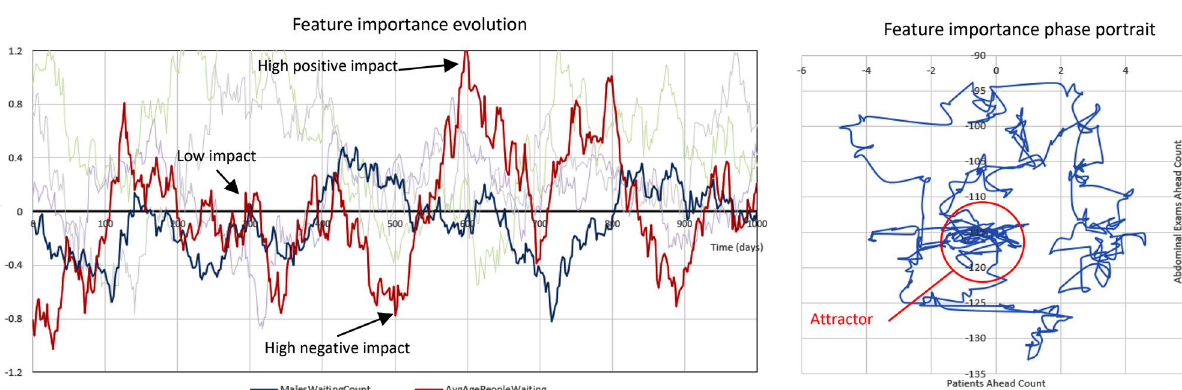
Figure 6. Left: Feature contributions to the final model outcome, changing in time (ridge regression model, patient wait time dataset). We used a 3-month sliding window along the time axis, computing normalized feature importance values for each window position. As a result, the plot visualizes the temporal evolution of individual feature impacts on the model outcome, with two features shown in the foreground, and more in the faded background. Right: Model temporal path, traced in the phase space of its two feature (importance) values. Note another attractor area in the center, and the overall circular shape of the model path, significantly changing between the two